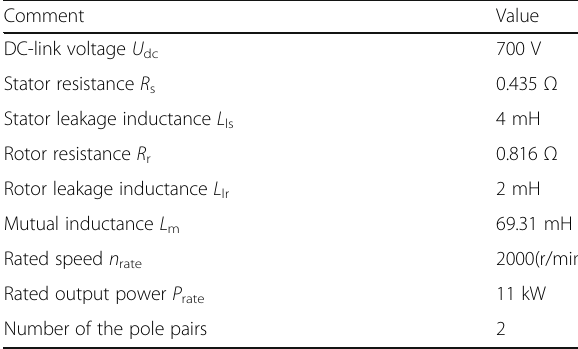
Table 2 Parameters of the drive